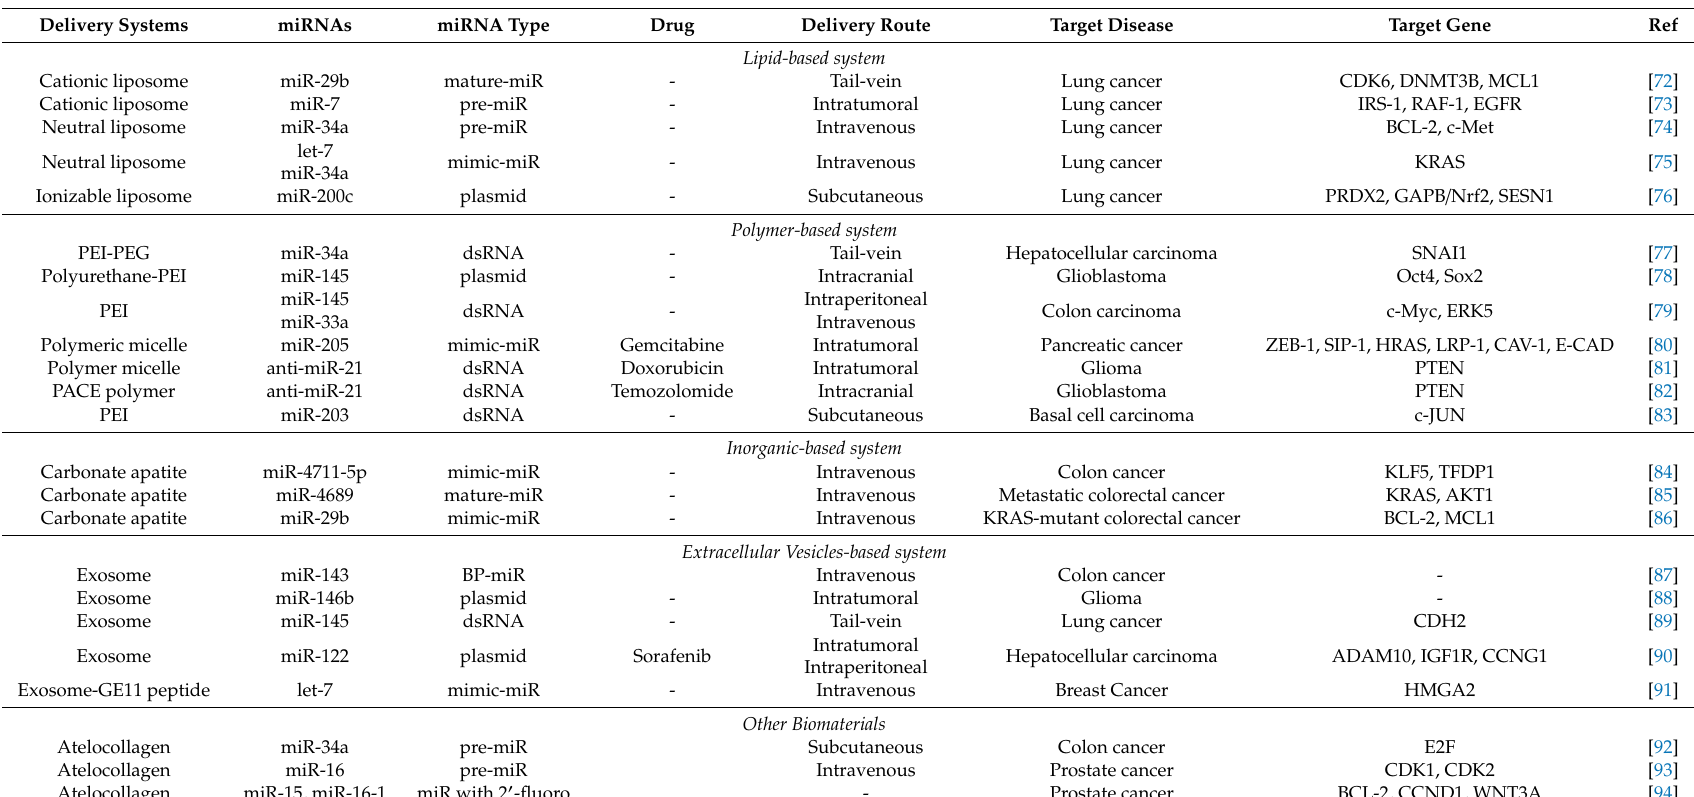
Table 1. The Summary of MicroRNA (miRNA) Mimics or Inhibitors Tested in